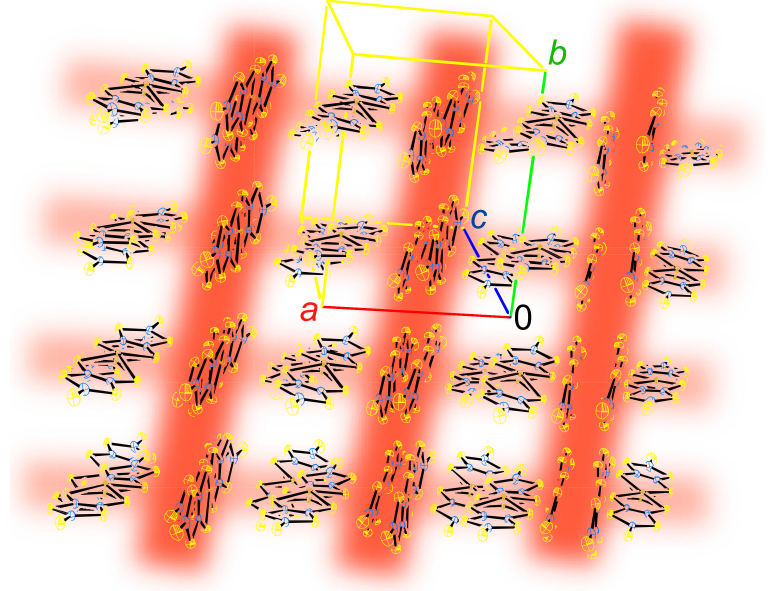
Figure 11. Interaction network between the Au(dmit) 2 anions in BPY[Au(dmit) 2 ] 2 . The yellow, blue, and light brown spheres designate sulfur, carbon, and gold atoms, respectively. BPY cations are omitted for clarity. Reproduced from Ref. [13] with permission from the Royal Society of